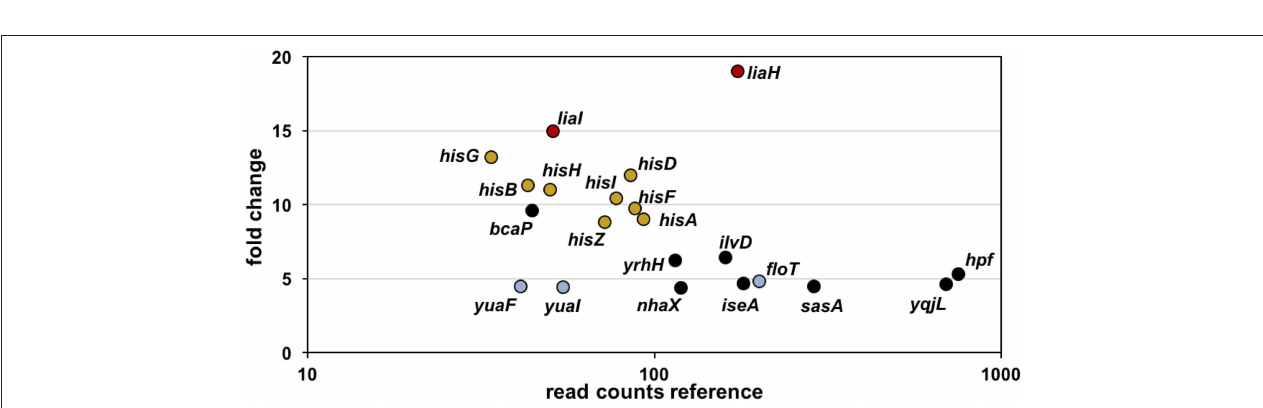
FIGURE 3 | RNA-sequencing (RNA-seq) profile of B. subtilis upon YydF* treatment. Visualization of altered gene expression in B. subtilis upon 0.5 µ M YydF* exposure after 10min, compared to non-induced control samples. Fold change of elevated RNA-seq counts are plotted over read counts in the reference condition. Same colored dots highlight genes encoded within an operon. For further details, see Table 1 and Table S2